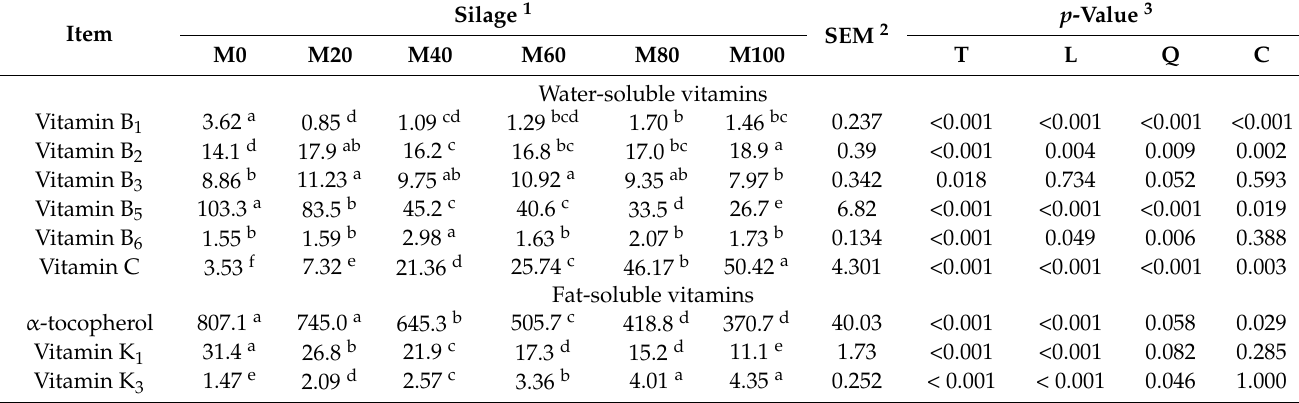
Table 3. Vitamin profile (mg/kg DM) of silage prepared with lucerne, sweet maize stalk, and their mixtures ( n =